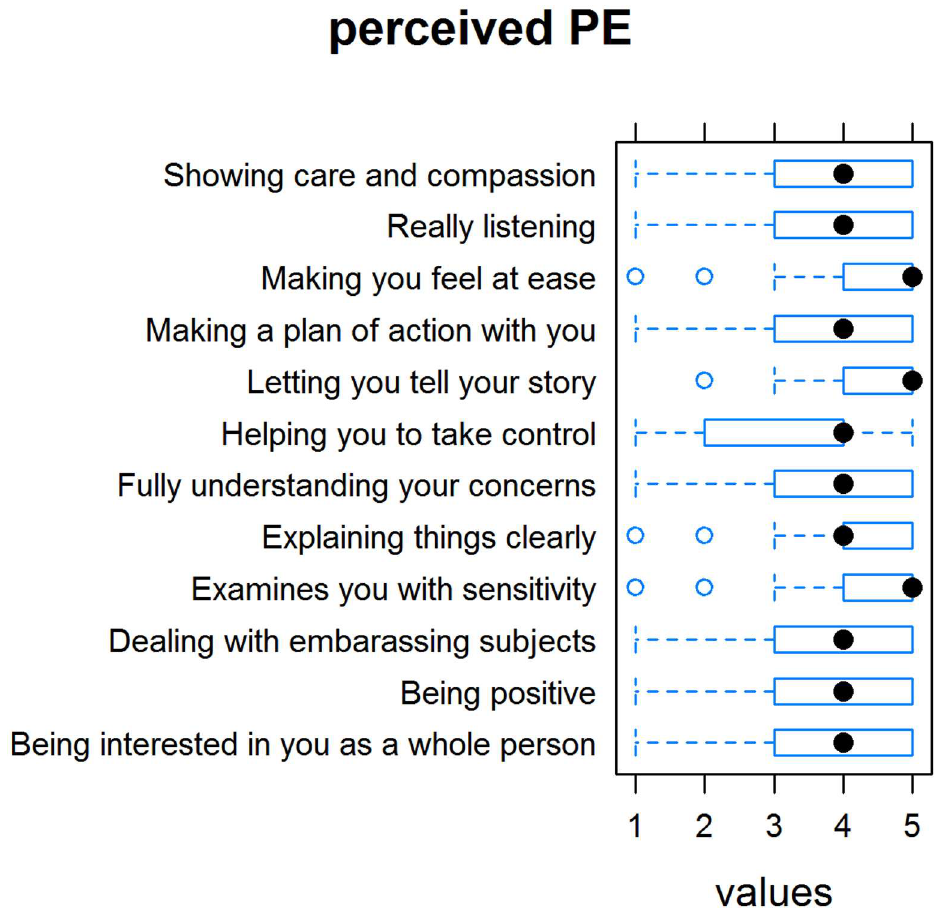
Fig 2. Ratings of “perceived empathy” items on the Consultation and Relational Empathy (CARE)